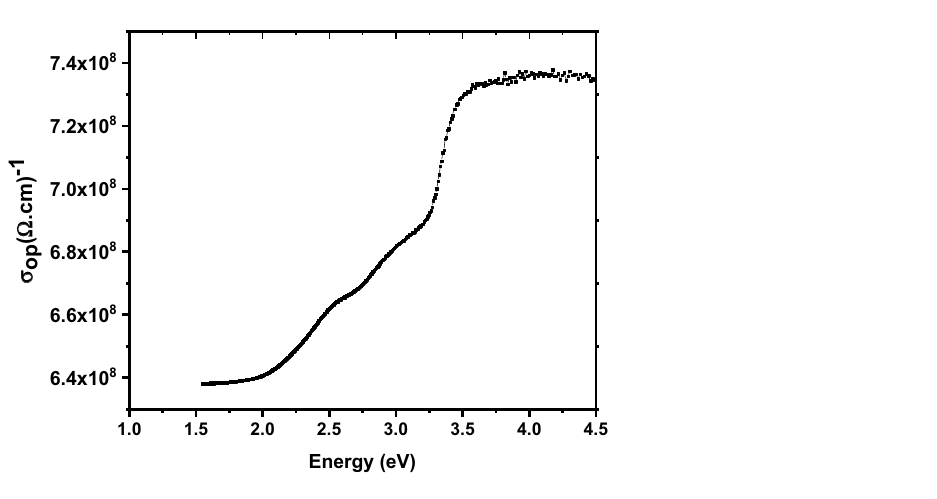
Figure 8. Optical conductivity as a function of photon